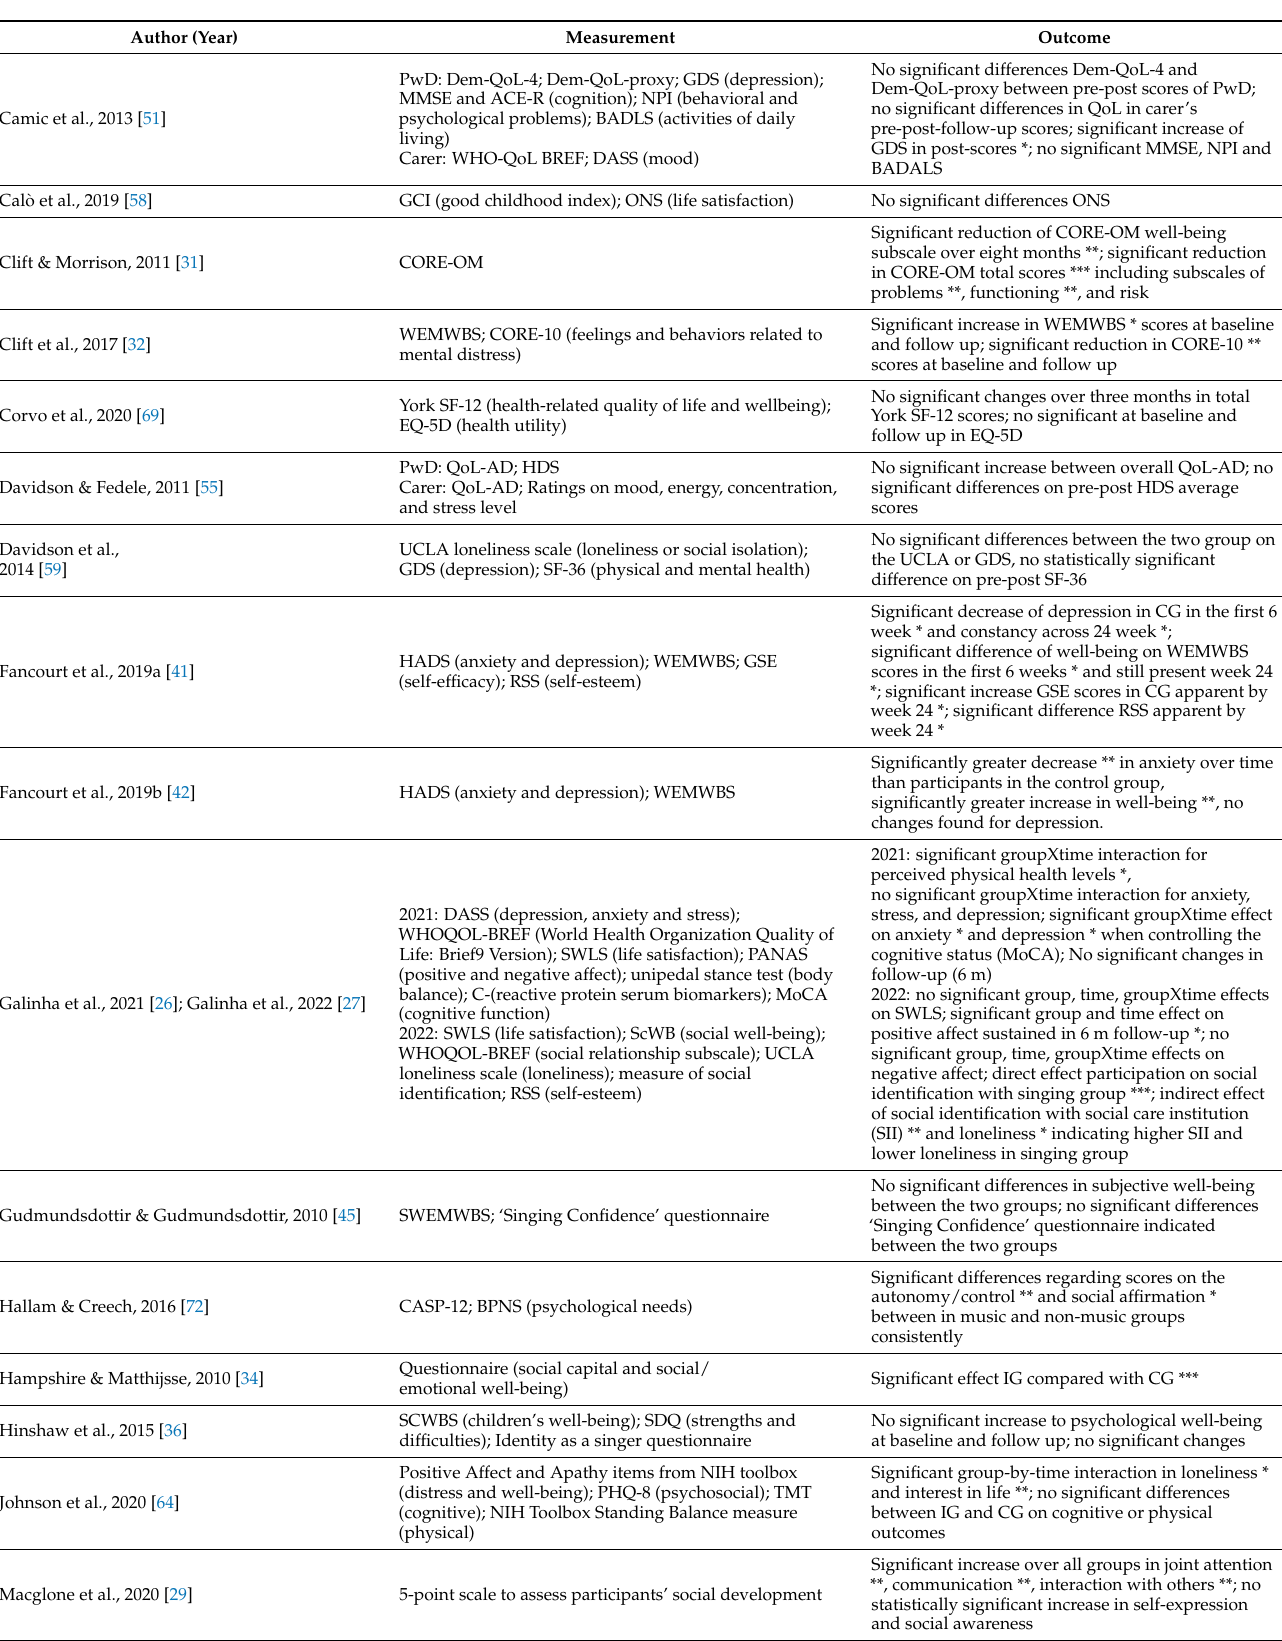
Table A3. Summary of quantitative